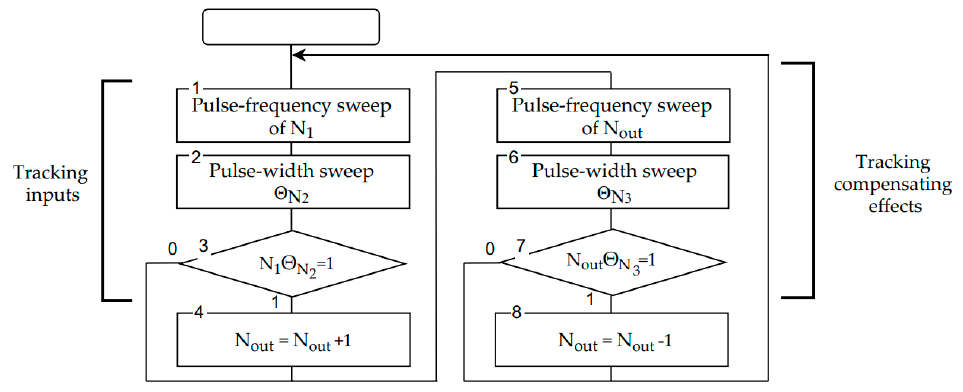
Figure 3. Algorithm of the multiplication-division operation.